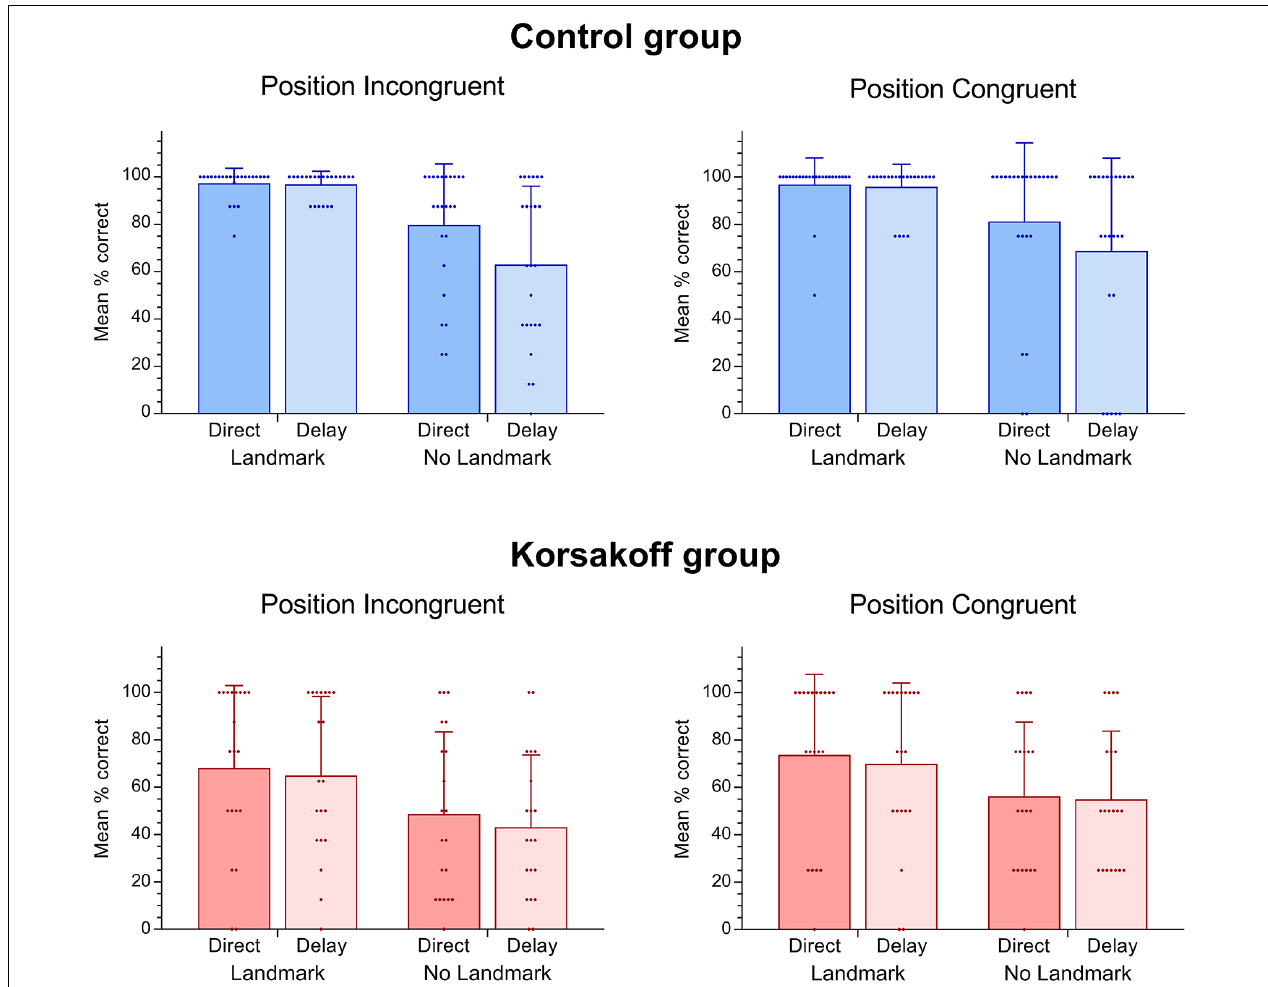
FIGURE 4 | Means and standard deviations as well as scatter dots of individual performance in the virtual spatial memory task for both controls and patients with Korsakoff’s syndrome